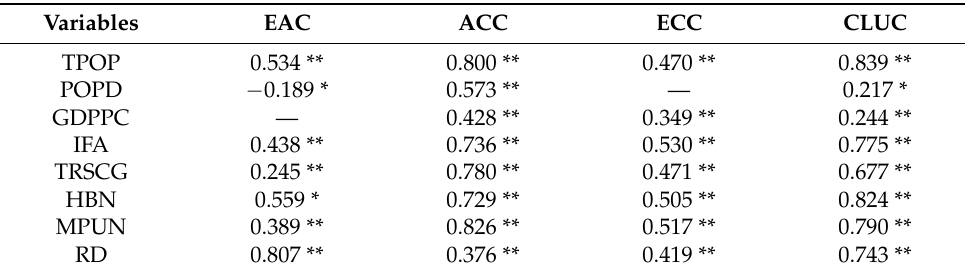
Table 7. Pearson correlation coefficients between the land use conflict indices and socioeconomic factors. Variables EAC ACC ECC CLUC TPOP 0.534 ** 0.800 ** 0.470 ** POPD − 0.189 * — GDPPC — 0.428